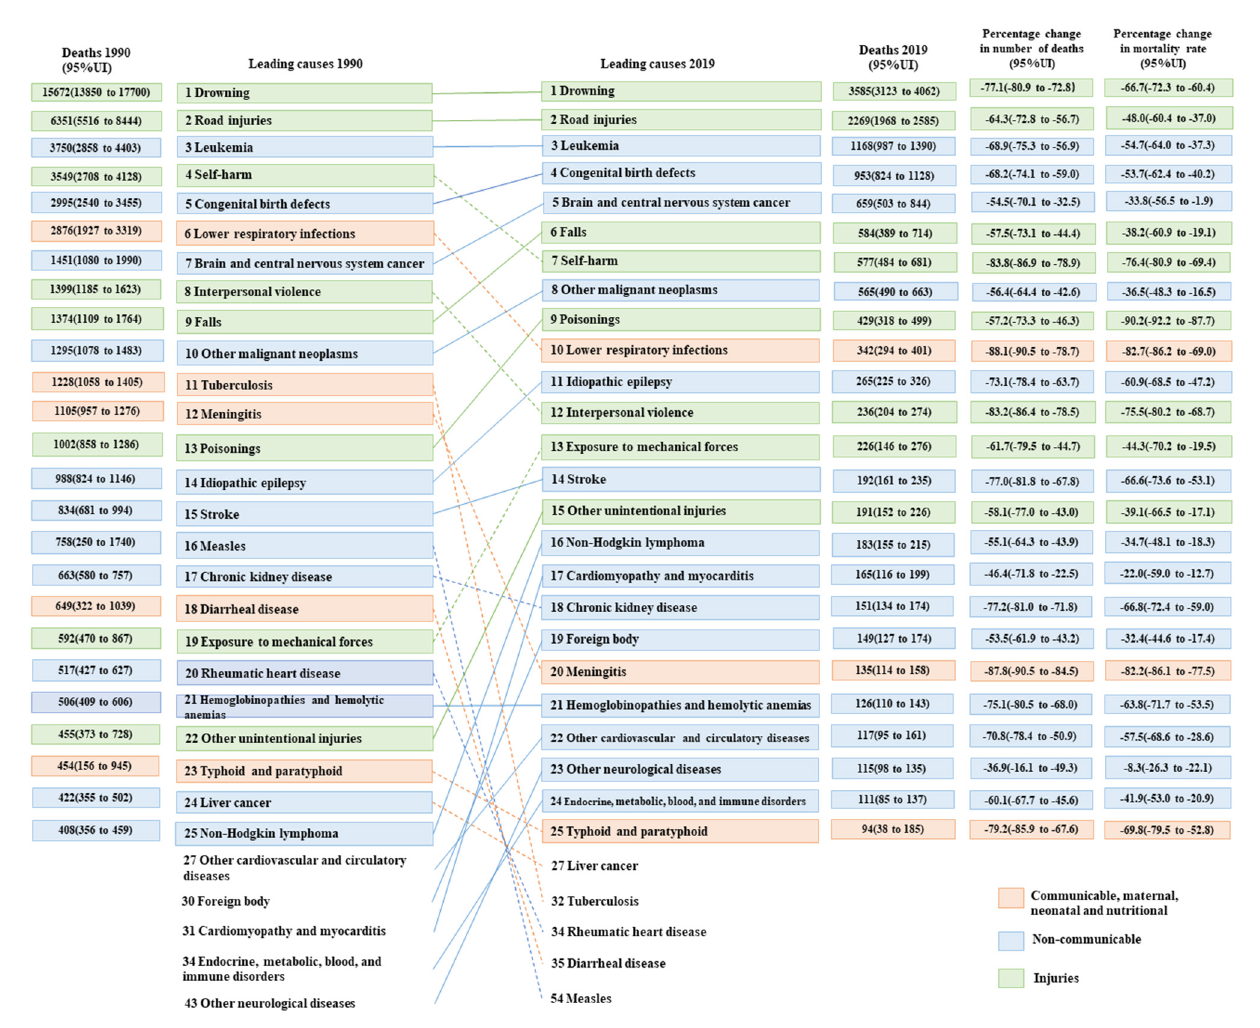
FIGURE4 Top 25 causes of death in China, aged 10–14 years, both sexes, 1990 and